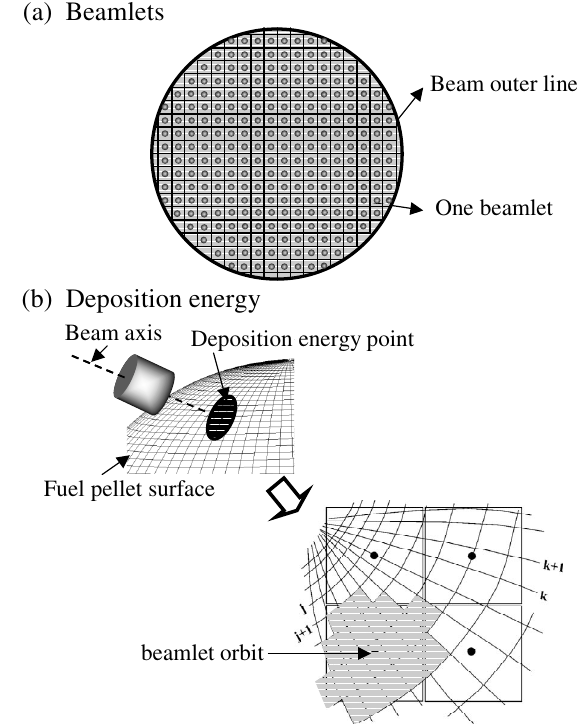
FIG. 4. (a) Beamlet. Each beamlet deposits its energy in the spherical target, then the deposition energy is divided into mesh points on the spherical target. (b) Deposition energy at each mesh point. The beamlets have an effective area. The deposition energy at a mesh point is defined from the beamlet effective area.